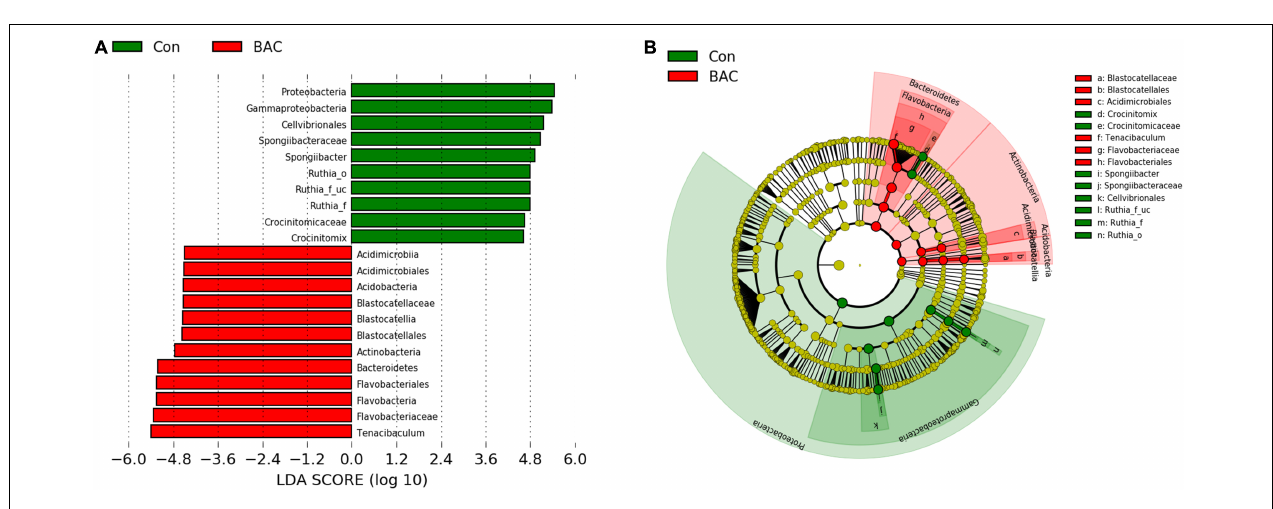
FIGURE 4 | Linear discriminant analysis effect size (LEfSe) analysis of differential abundance of taxa within A. japonica microbiota from each group. (A) Linear discriminant analysis (LDA) score of abundance of taxa; (B) cladogram showing differentially abundant taxa between the two groups of phylum to